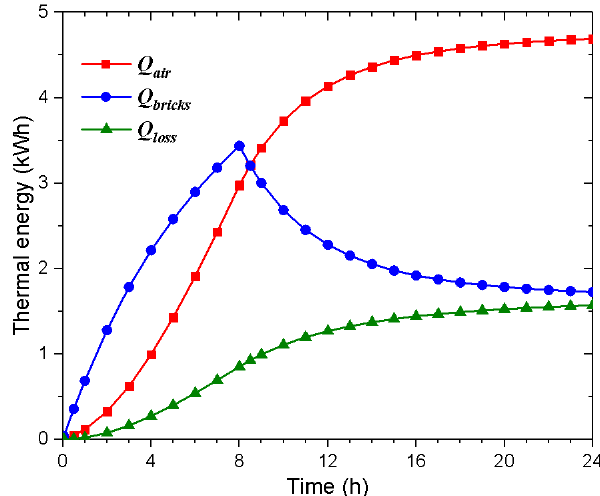
Figure 11. The total energy transferred to the air Q air , stored by the bricks Q bricks and lost to the space Q loss during the charging and discharging processes.